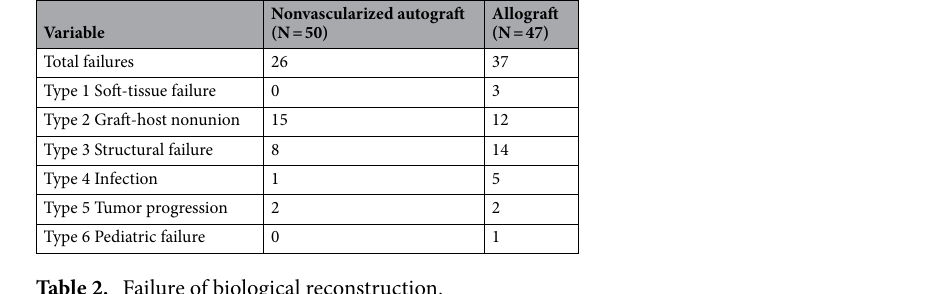
Table 2. Failure of biological